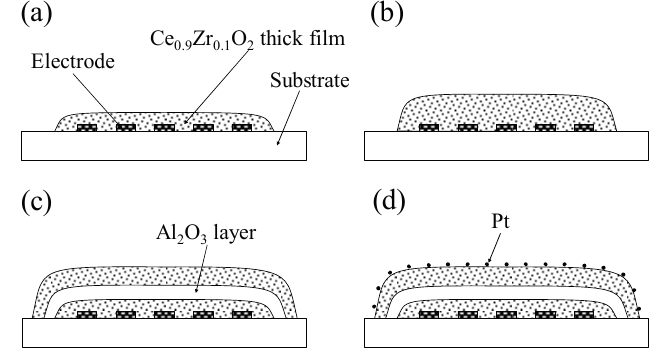
Figure 1. Drawings of cross sections of thick-film sensors: ( a ) CeZr10; ( b ) CeZr10 × 2; ( c ) CeZr10/Al 2 O 3 /CeZr10; ( d ) CeZr10/Al 2 O 3